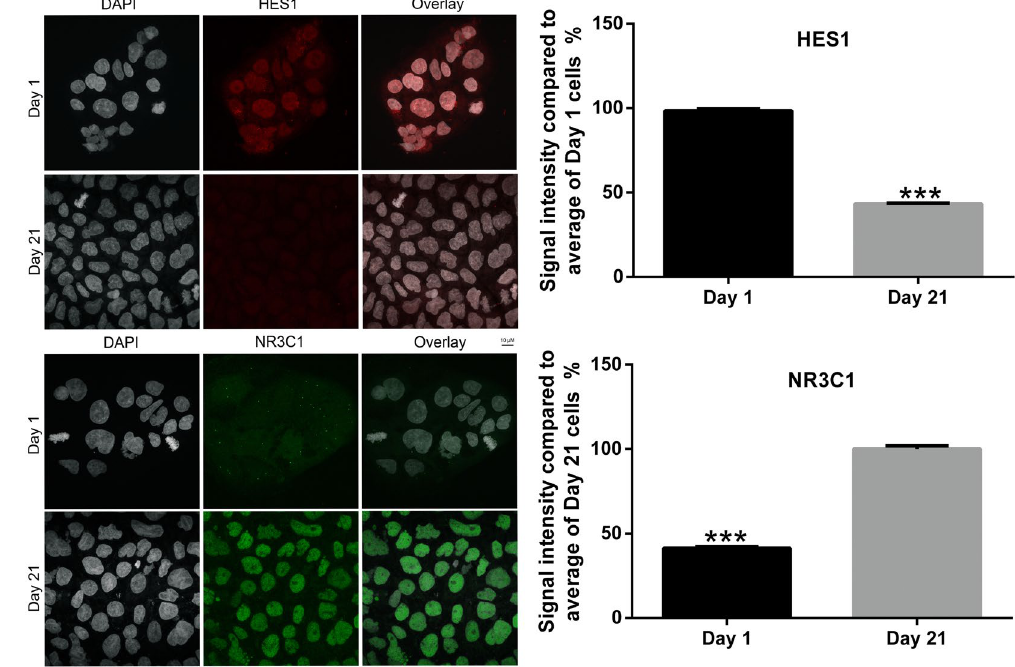
Figure 7. Single-cell resolution quantification of HES1 and NR3C1 proteins in Caco-2/BBe cells before and after 21-day differentiation. Caco-2/BBe cells were fixed at day 1 and day 21 of 21-day differentiation and immuno-stained with HES1 and NR3C1 antibodies for confocal imaging. 100 cells from each group were randomly selected for nucleus immunofluorescence signal quantification. Day 21 cells showed significantly lower nucleus HES1 signal (44.0 ± 0.1%) compared to day 1 cells. Day 1 cells showed only 41.3 ± 0.1% nucleus NR3C1 signal compared to day 21 cells. (n = 100; *** P <